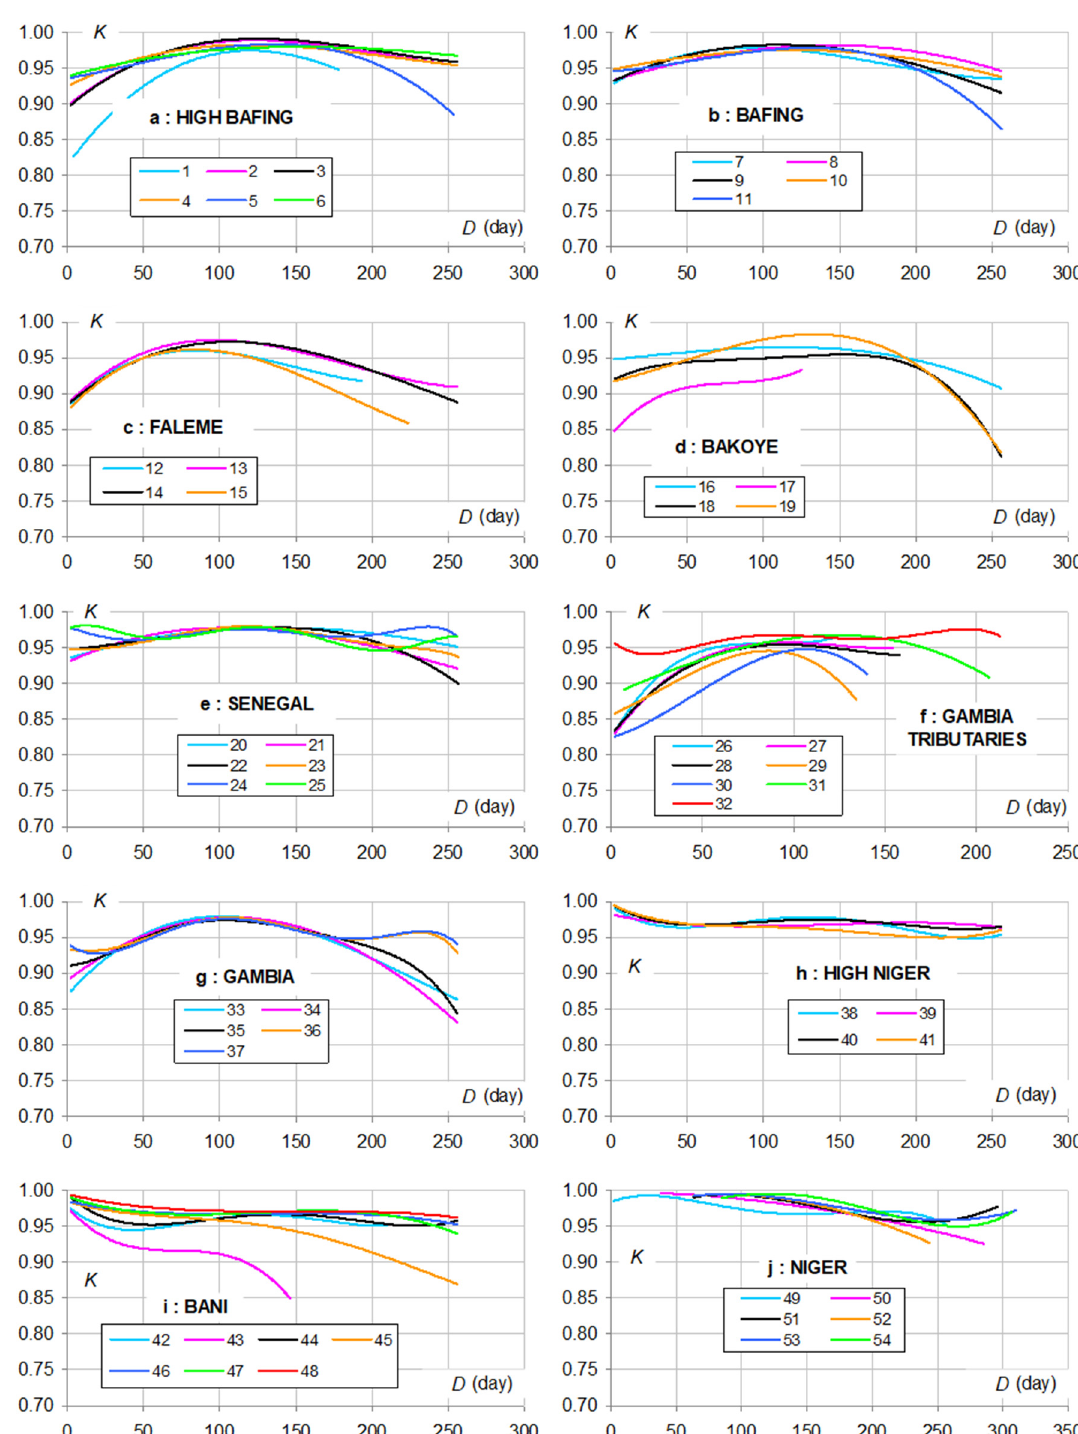
Figure 6. Model 1 representing K as a function of the time D elapsed since the previous 15 September ( K = f ( D )) at the 54 stations located in the Senegal, Gambia and Niger basins, by sub-basins: High Bafing ( a ); Bafing ( b ); Faleme ( c ); Bakoye ( d ); Senegal ( e ); Gambia tributaries ( f ); Gambia ( g ); High Niger ( h ); Bani ( i ); Niger ( j